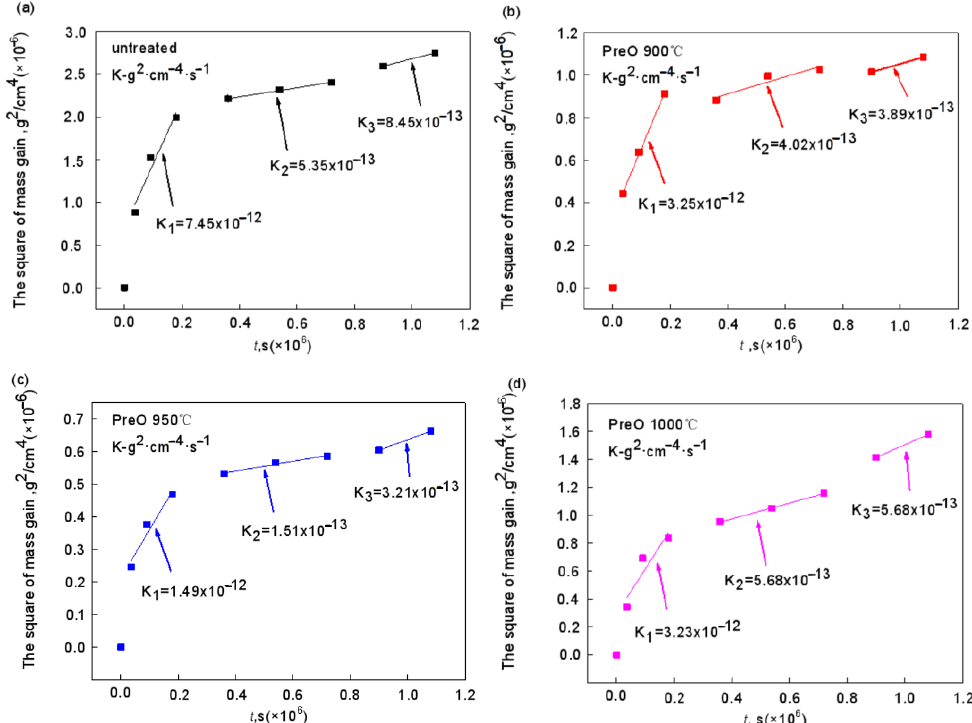
at 1000 ◦ C: ( a ) untreated; ( b ) 900 ◦ C; ( c ) 950 ◦ C; ( d ) 1000 ◦ Figure 22. Parabolic rate constant curves of Al-Si coatings under different pre-oxidation tempera- tures at 1000 °C: ( a ) untreated; ( b ) 900 °C; ( c ) 950 °C; ( d ) 1000 °C.